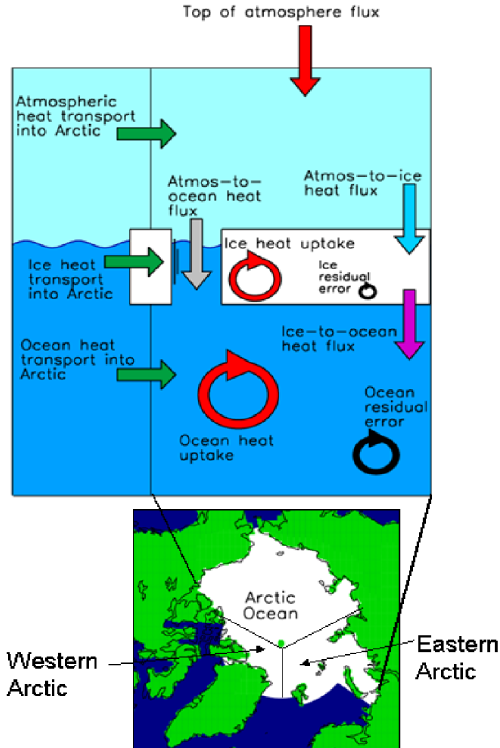
Fig. 4. Schematic to show how the Arctic heat budget was cal- culated. The bottom panel shows the Arctic Ocean as defined in Sect. 3. The western Arctic and eastern Arctic regions used in Sect. 3.3 are also